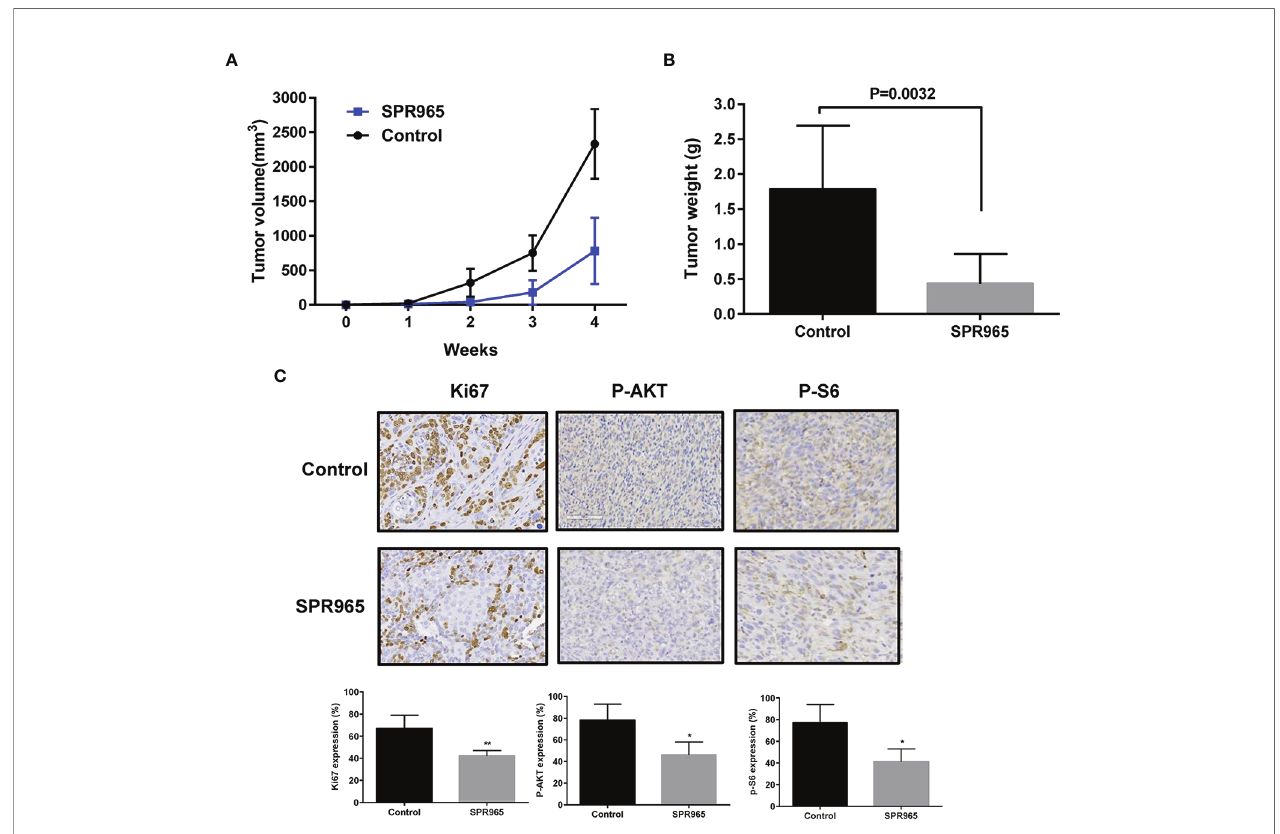
FIGURE 3 | SPR965 inhibited tumor growth in KpB mice. KpB mice were treated with vehicle (control) or SPR965 (3 mg/kg, oral gavage) for 4 weeks when the tumors reached 0.1 – 0.2 cm in size. SPR965 signi fi cantly inhibited tumor volume and tumor weight (N=15 animals per group) as compared to the vehicle treated controls (A, B) . Immunohistochemistry results showed that SPR965 decreased the expression of Ki-67, phos-S6, and phos-AKT in the ovarian tumor tissues (C) . *p < 0.05; **p <